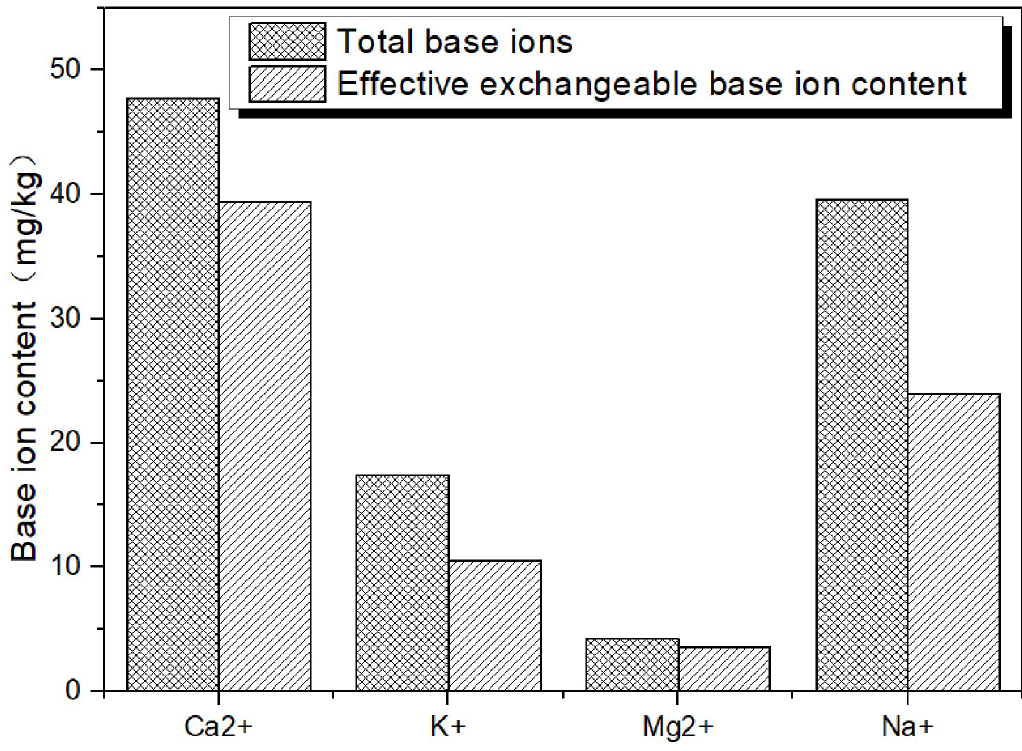
Fig 10. Base ions content in soil. (Cartographic software:Origin